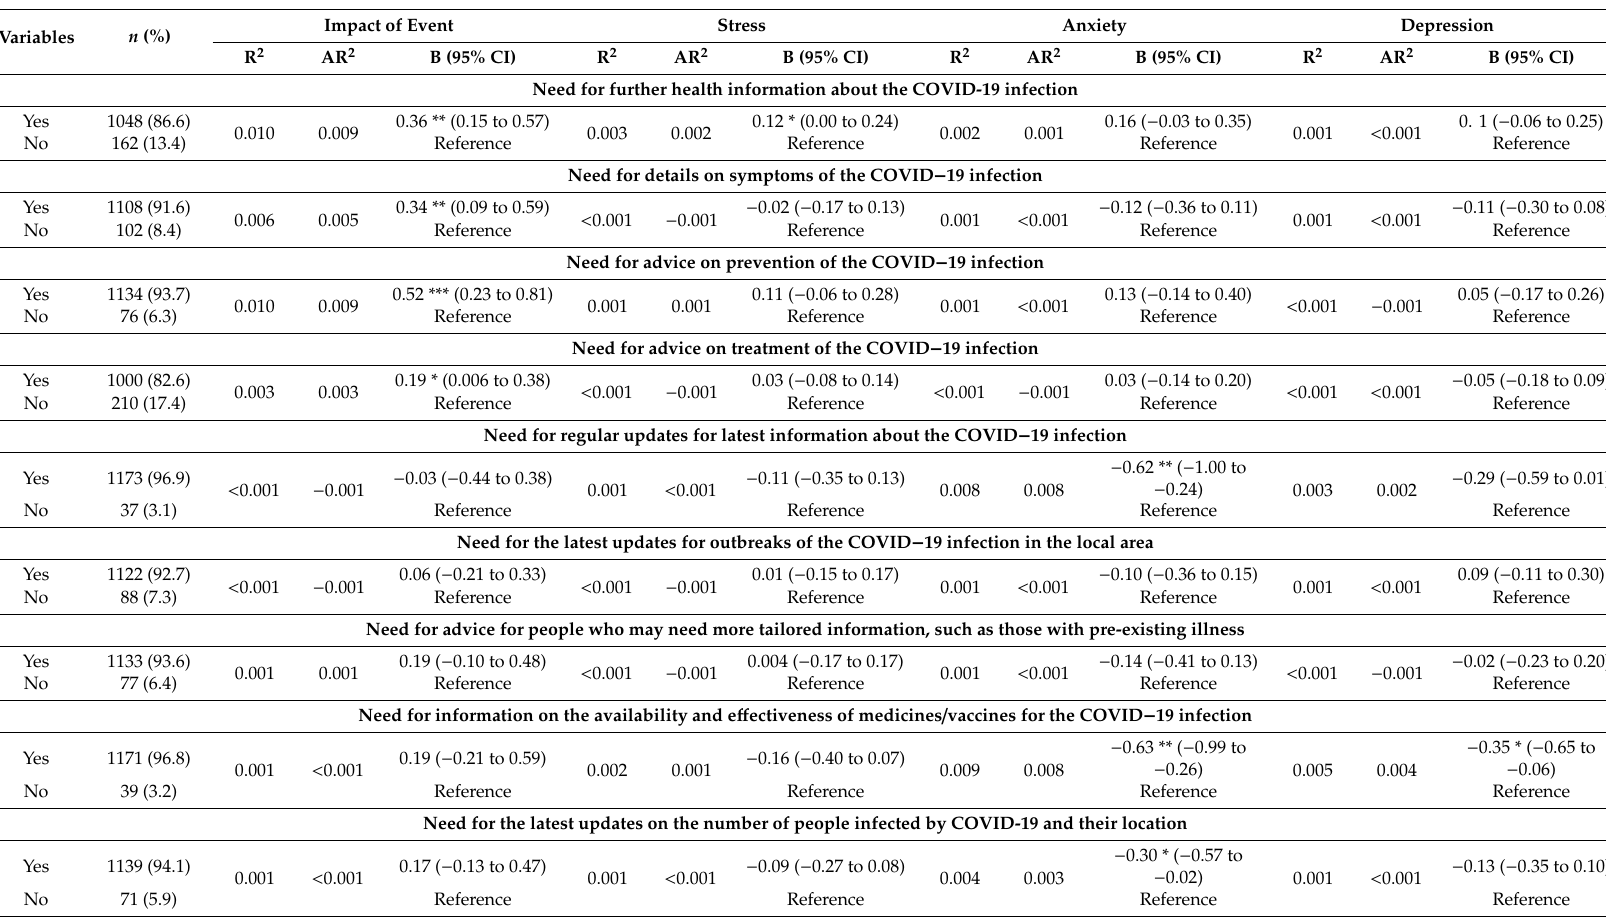
Table 6. Association between additional health information required by participants and the psychological impact of the 2019 coronavirus disease (COVID-19) outbreak as well as adverse mental health status during the epidemic ( n =